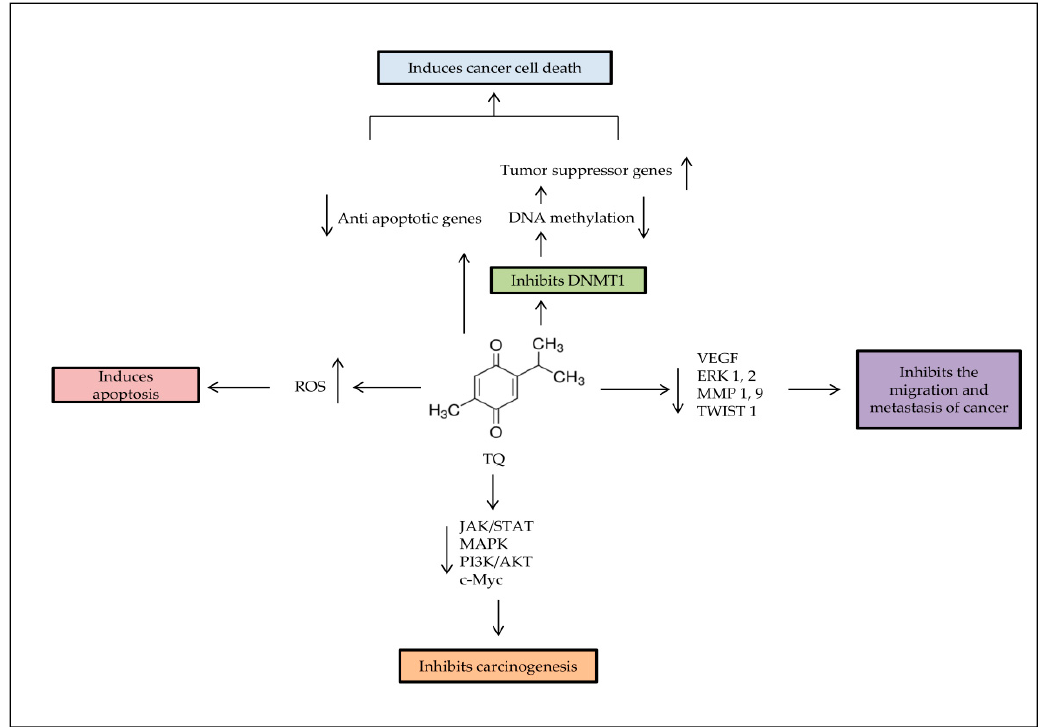
Figure 2. Major anti-tumorigenic properties of TQ. Apoptosis is induced by TQ in cancer cells through producing ROS, demethylating and re-expressing the TSG. TQ inhibits the survival signaling pathways to reduce carcinogenesis progress rate, and decreases cancer metastasis through regulation of epithelial to mesenchymal transition (EMT).